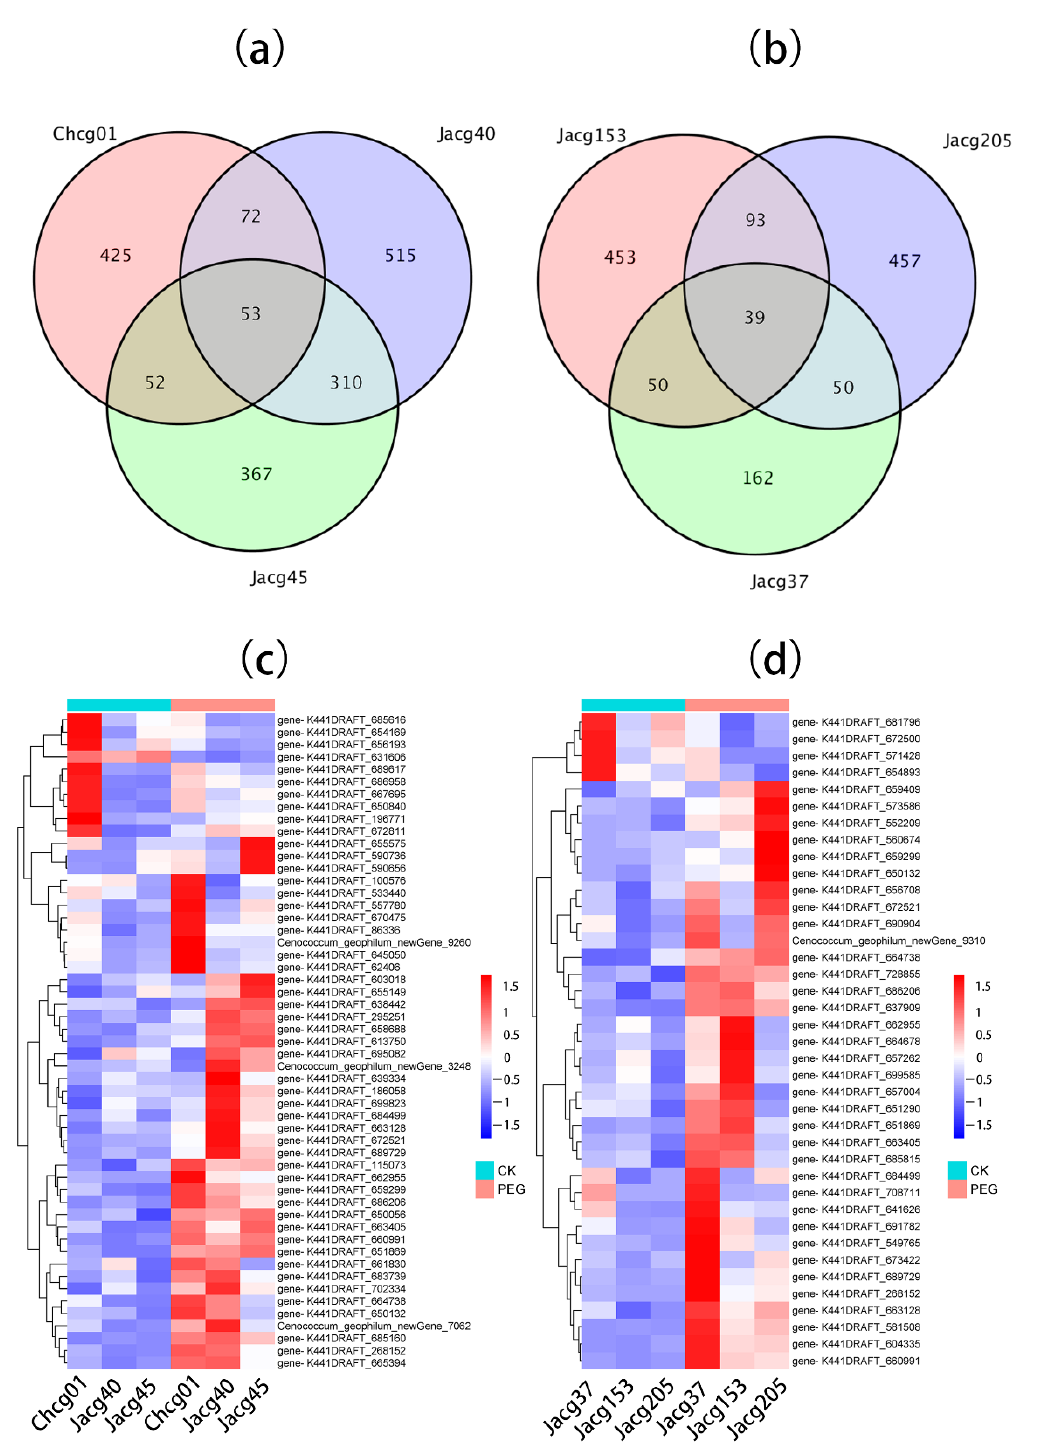
Figure 5. Genome analysis of the DEGs in six strains of Cenococcum geophilum between the drought (10% PEG 6000, PEG) and the control treatments (0% PEG 6000, CK). ( a , b ) indicate the Venn diagrams of total DEGs in the 3 drought-sensitive strains (Chcg01, Jacg40, and Jacg45) and the 3 drought-tolerant strains (Jacg37, Jacg153, and Jacg205) of Cenococcum geophilum after 10% PEG-6000 treatment compared to the control treatment (0% PEG 6000), respectively. ( c , d ) indicate the heatmaps of 53 common genes for the Chcg01, Jacg40, and J45 strains and 14 common genes for the Jacg37, Jacg153, and Jacg205 strains after drought treatment, respectively. The different colors of the heatmap, ranging from blue over white to red, represent scaled expression levels of genes with [log2 (FPKM + 1)] across different samples.